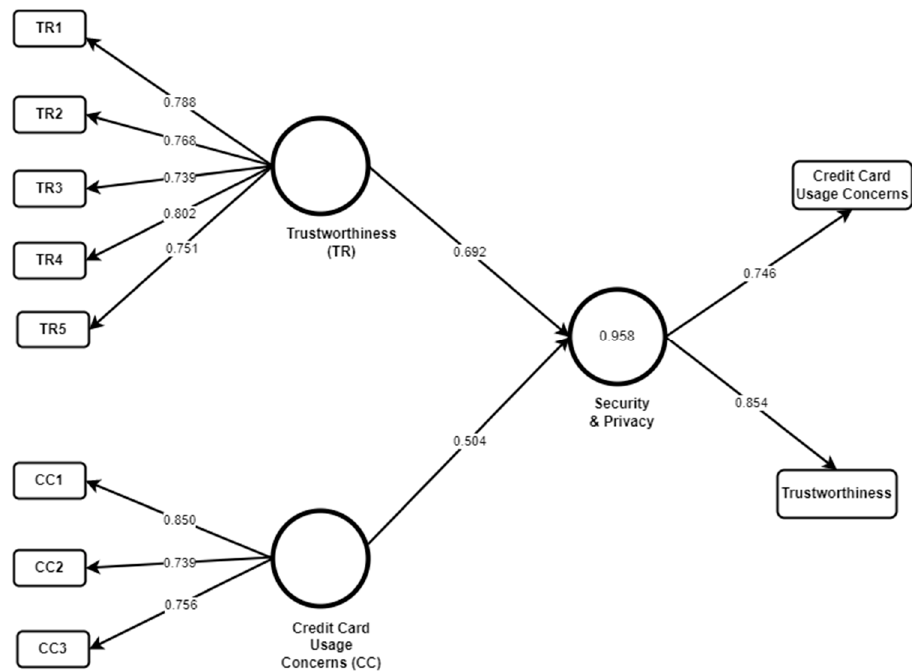
Figure 4. Hunger Station model.